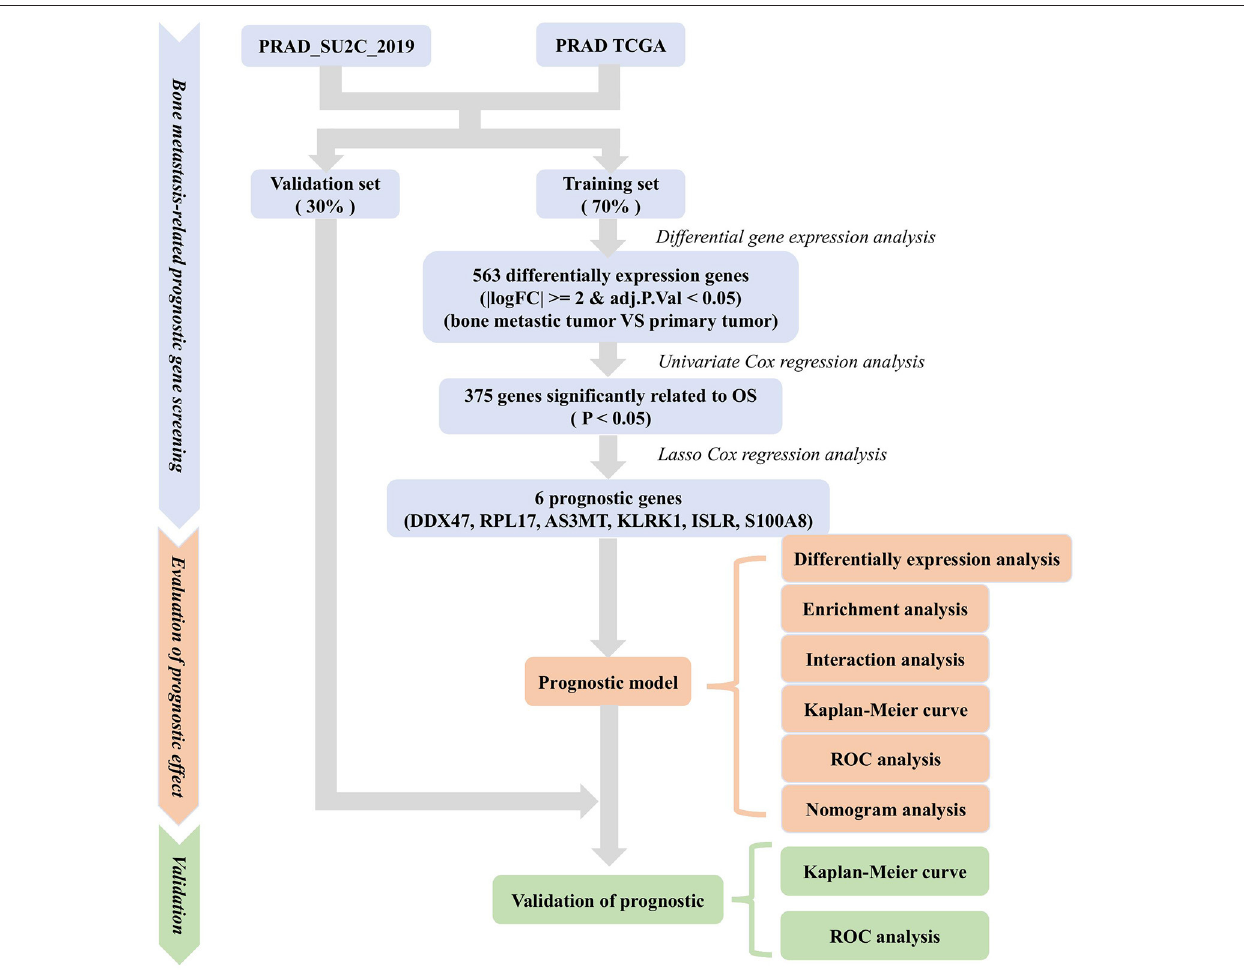
FIGURE 1 | Methodology for screening prognostic genes for bone metastases and constructing prognostic models.